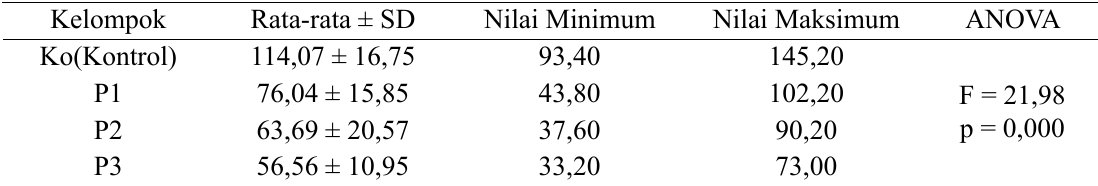
Tabel 3. Analisis jumlah spermatid oval untuk kelompok kontrol, kelompok perlakuan yang diberi injeksi subkutan epinefrin dosis 0,001 mg/20 gram BB, dosis 0,005 mg/20 gram BB dan dosis 0,01 mg/20 gram